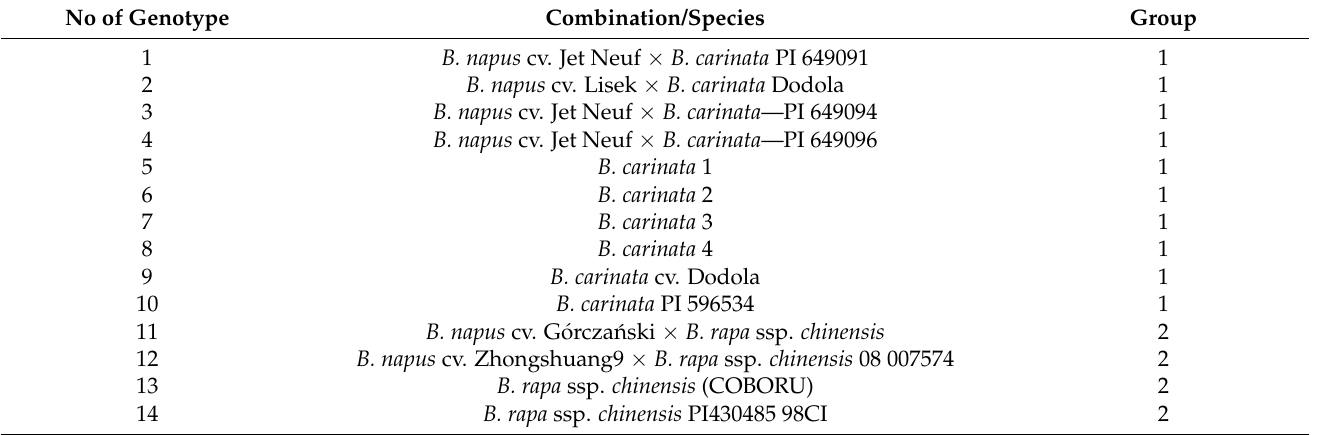
Table 1. List of Brassicaceae genotypes used in this study and groups for the analysis of molecular variance